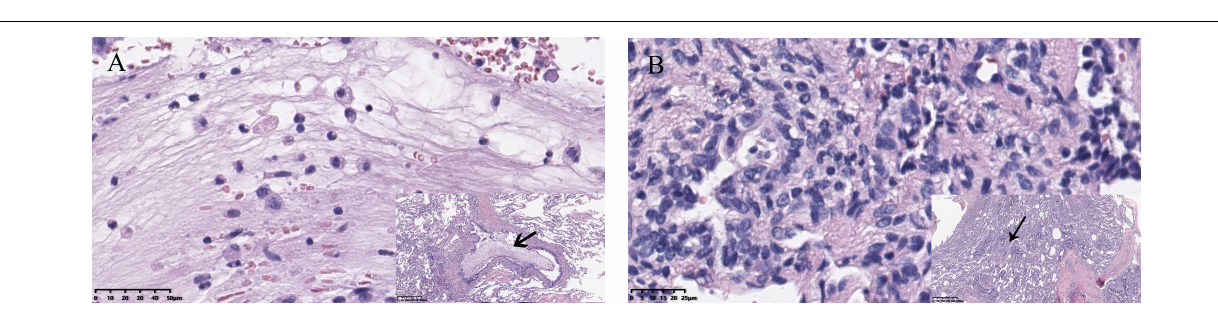
FIGURE 3 | (A) Neutrophil infiltration, which always indicates acute inflammation. Viscous exudate in the bronchioles was also found. (B) Lymphocyte infiltration, representing chronic infection, and thickening of blood vessel walls could also be